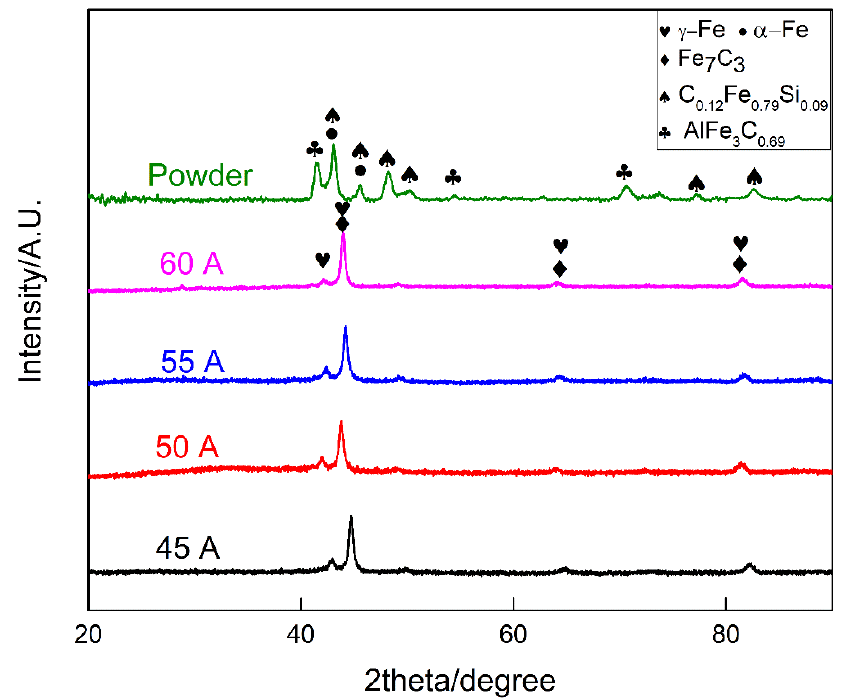
Figure 8. X-ray diffraction plots of the powder and